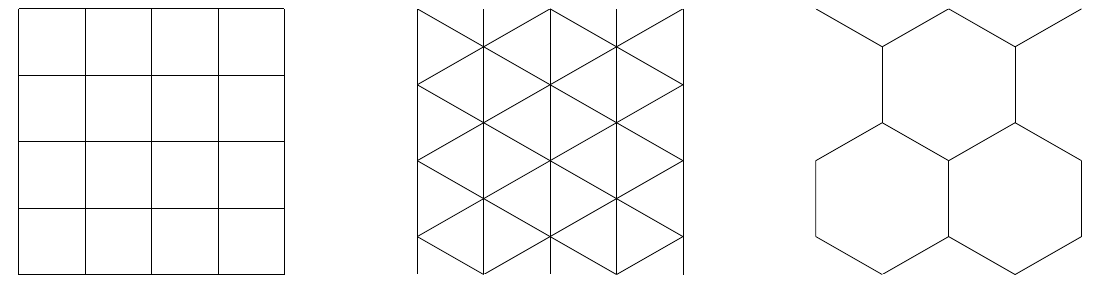
Figure 2 . The three types of (cid:12)shnets that have been proven integrable for, respectively, 4, 3 and 6 dimensional target spaces happen to coincide with the three regular tilings of (cid:13)at 2-dimensional